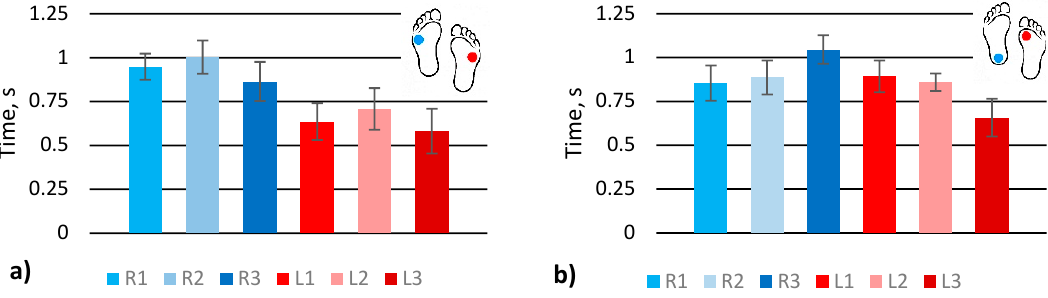
Figure 5. Analysis of stance phase duration at various gaits: ( a ) scrolling; ( b ) walk with one straight leg.